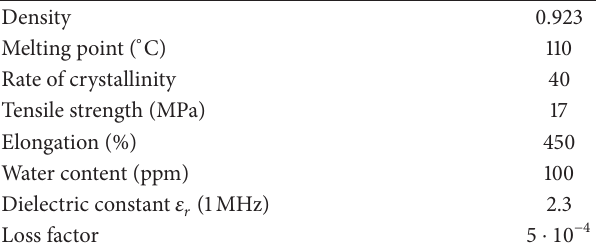
Table 1: Main characteristics of XLPE under study. Density